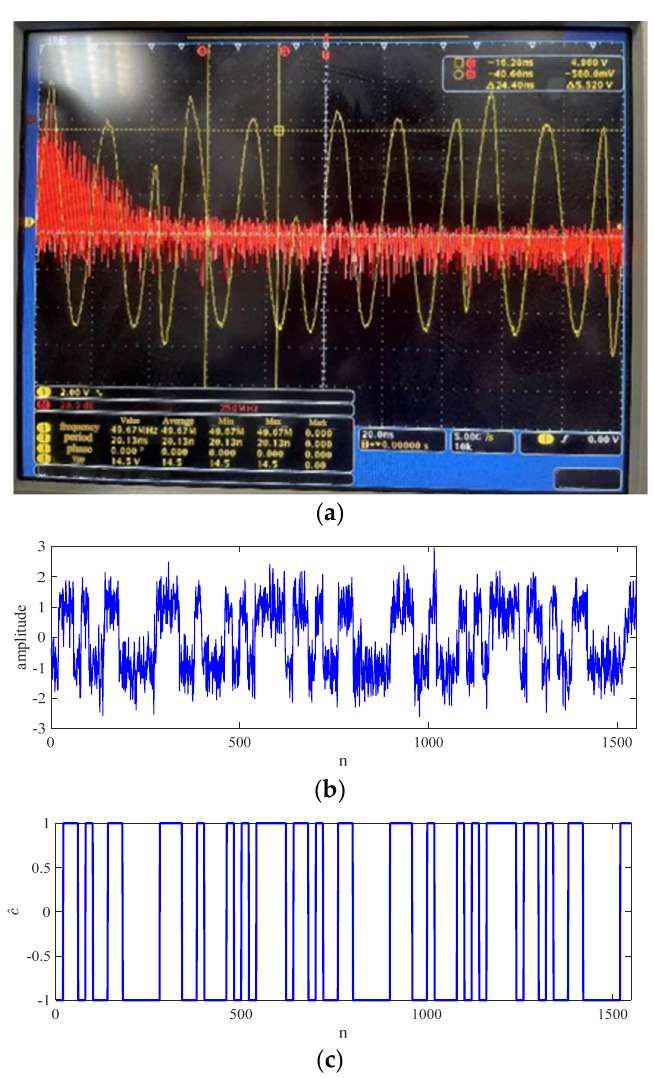
Figure 12. Results of the semiphysical tests. ( a ) The captured BPSK signal in the time domain and frequency domain. ( b ) The ZIF signal obtained from pretreatment. ( c ) The estimated PN codes.